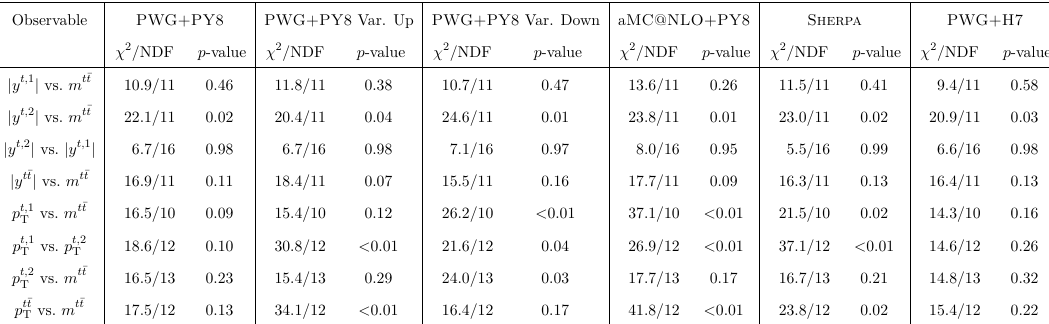
Table 14 . Comparison of the measured parton-level absolute double-differential cross-sections with the predictions from several MC generators. For each prediction, a χ 2 and a p -value are calculated using the covariance matrix of the measured spectrum. The number of degrees of freedom (NDF) is equal to the number of bins in the distribution.